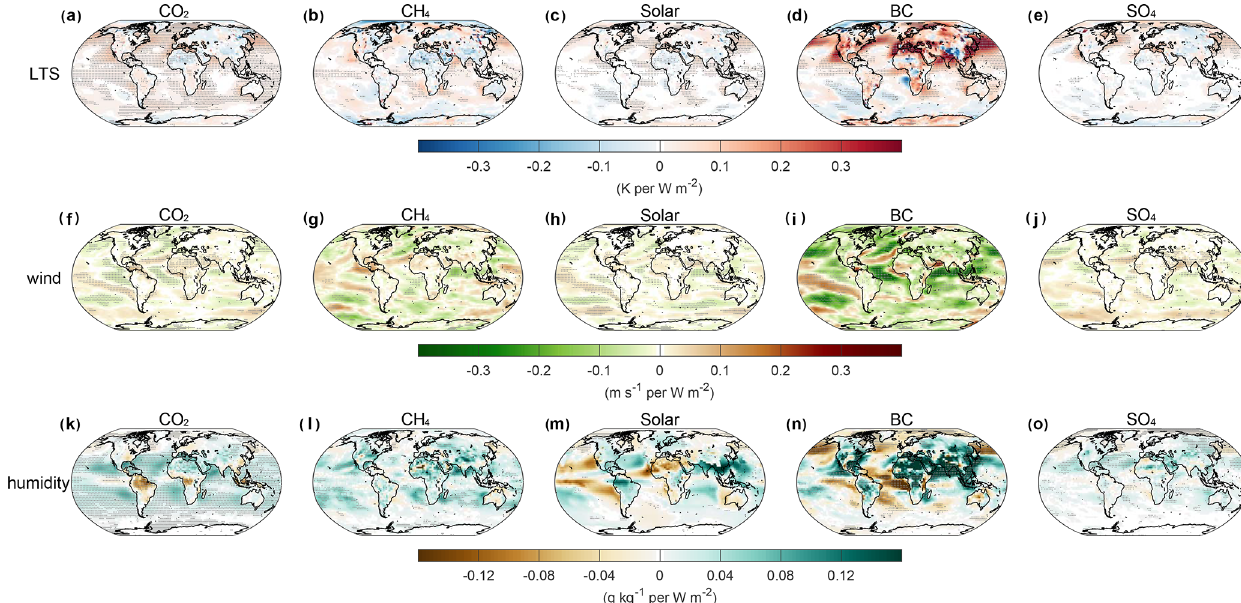
Figure 6. MMM changes for lower tropospheric stability (LTS, a–e ), surface wind velocity (f–j) , and humidity gradient (k–o) per unit of global TOA forcing. For LTS, positive anomalies indicate a more stable atmosphere. The humidity gradient is defined as the specific humidity difference between the surface and 850hPa. Grey dots indicate that the MMM changes are significant at a p value of 0.05.